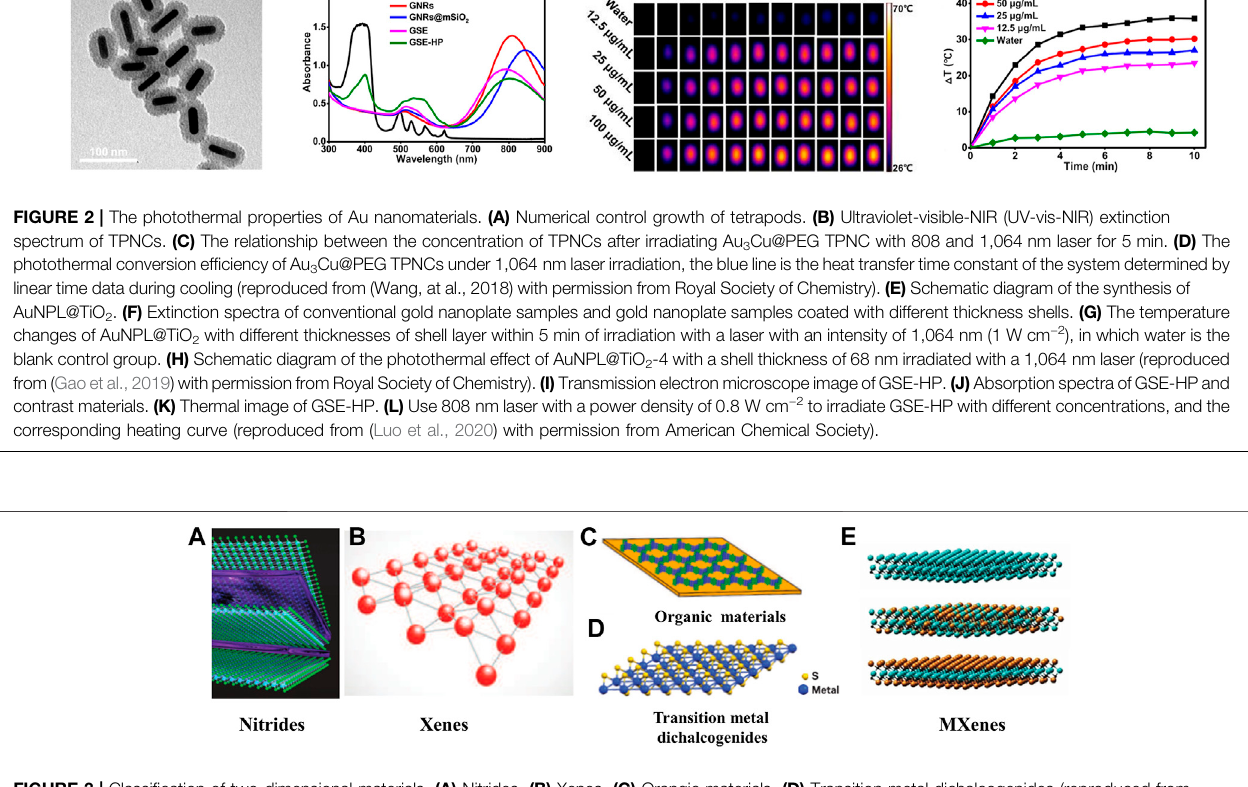
Frontiers in Chemistry |